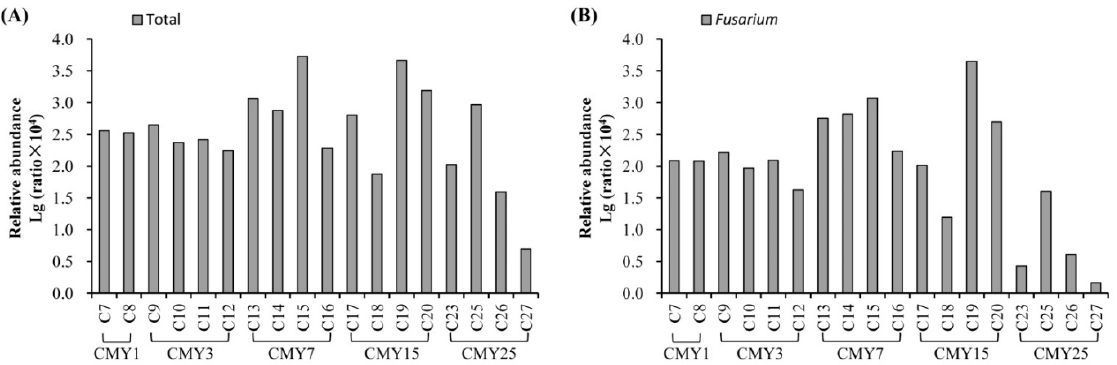
Figure 4. Relative abundance of operational taxonomic units (OTUs) potentially related to plant pathogenic fungi ( A ) and Fusarium spp. ( B ) under long-term cucumber monoculture soils.